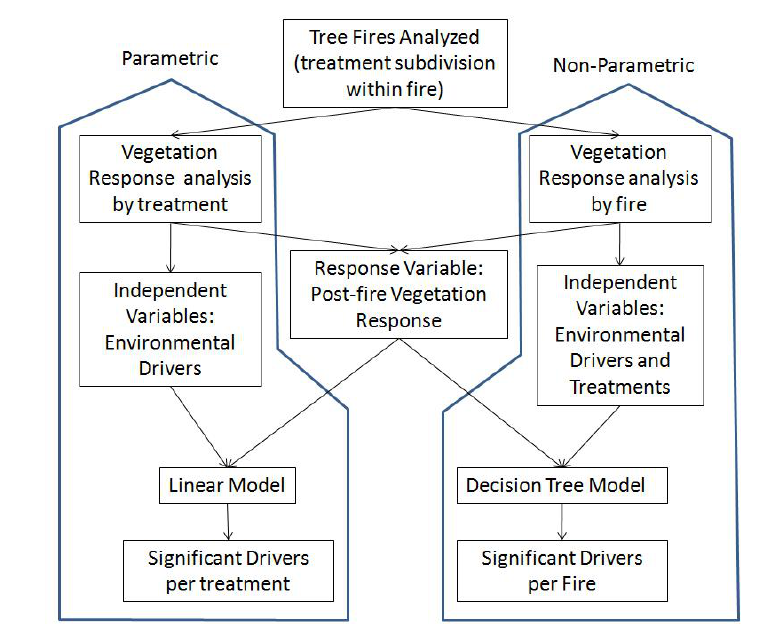
Figure 2. Parametric and non-parametric approaches were used to evaluate post-fire response drivers. Remotely sensed and ancillary datasets were used to derive response and explanatory